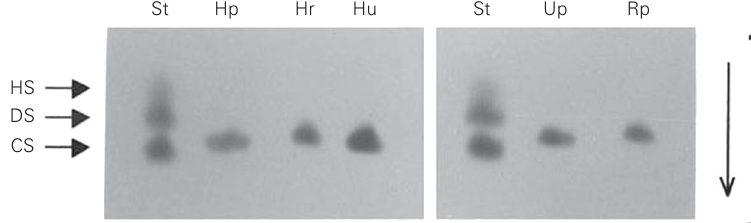
Figure 6. HPLC analysis of di- saccharides obtained after en- zymatic digestion with chondro- itinase ABC using an anion-ex- change Spherisorb-SAX column and NaCl gradient ranging from 0 to 1.0 M. The eluate was monitored at 232 nm and each region was analyzed separately.